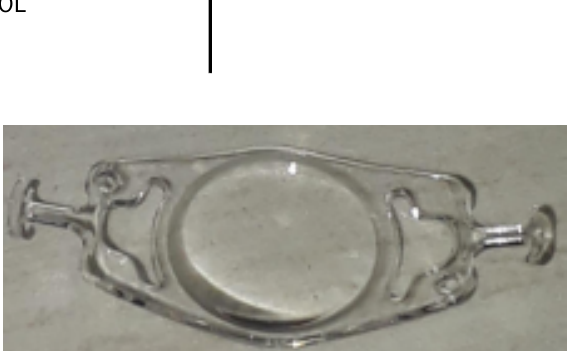
Figure 1: External photograph of the CM T-flex IOL Under peribulbar anaesthesia, using the Ashwin